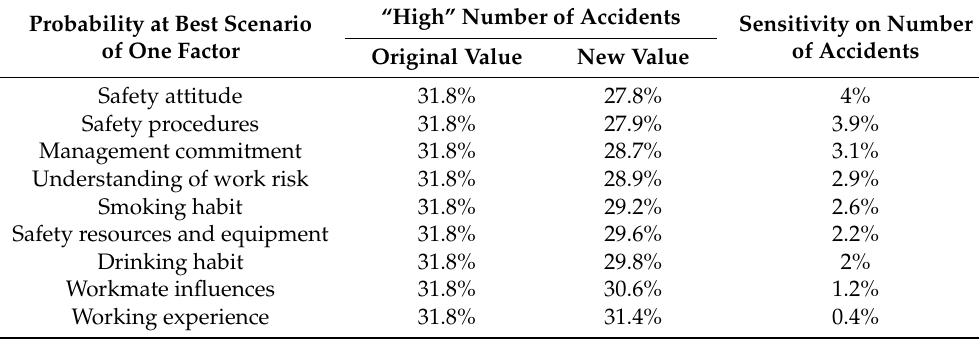
Table 5. Sensitivity of single strategy to reduce the number of